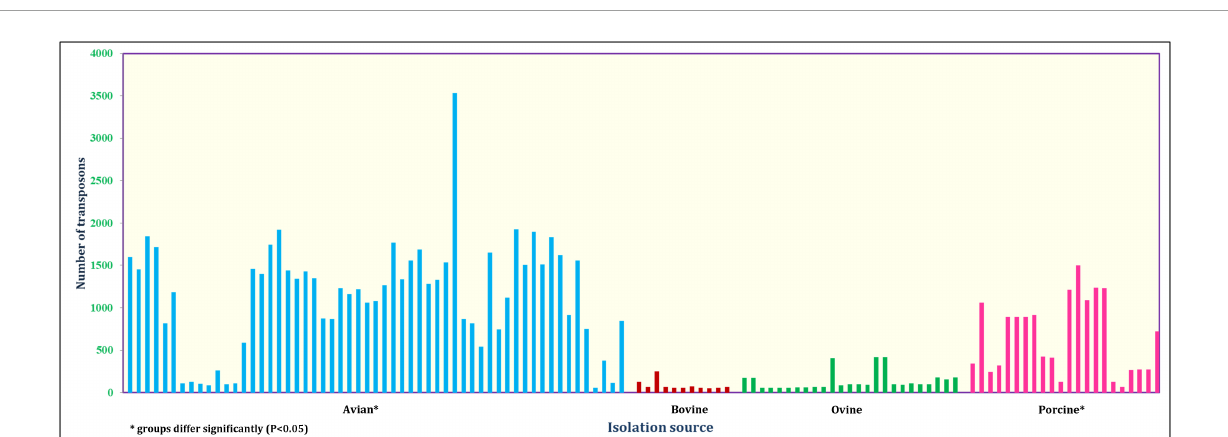
FIGURE5 Number of transposons identified in E. fergusonii